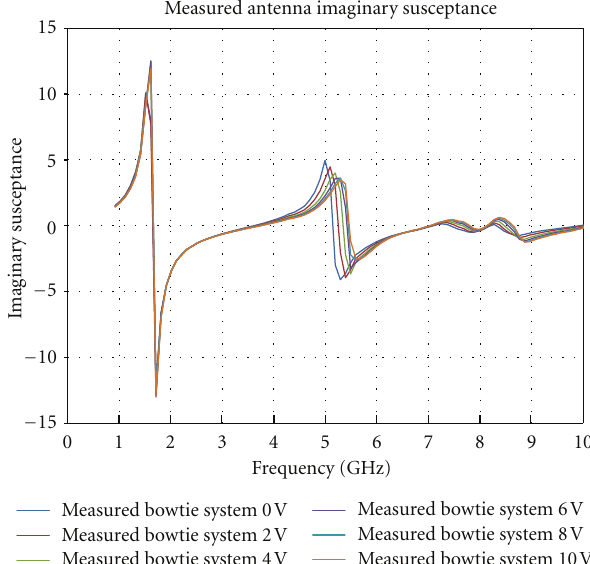
Figure 9: Measured susceptance versus frequency for the antenna system under 0–10 V DC